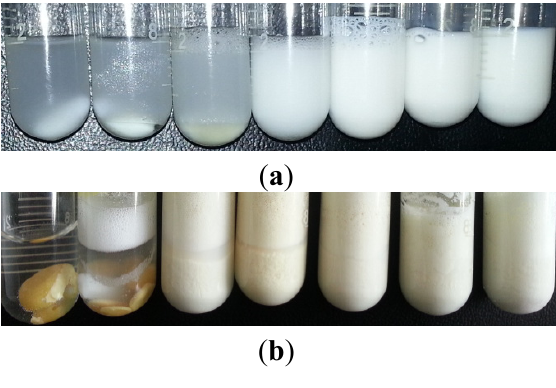
Figure 1. Different stages of the Mannich reaction catalyzed by GBAILs. ( a ) During the reaction; ( b ) at the end of reaction. The order of ionic liquids (ILs) from left to right